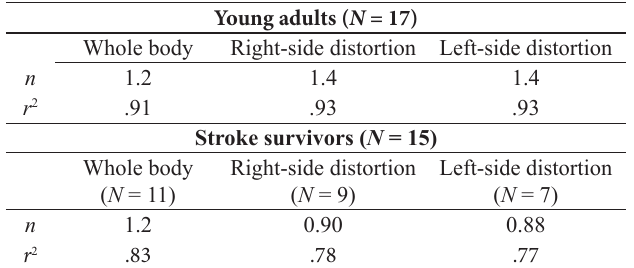
Table 6. Exponent of the psychophysical power function and the co- efficient of determination of participants in two groups: Young adults and stroke survivors performed an estimation of magnitude task in which their own body images were bisected.